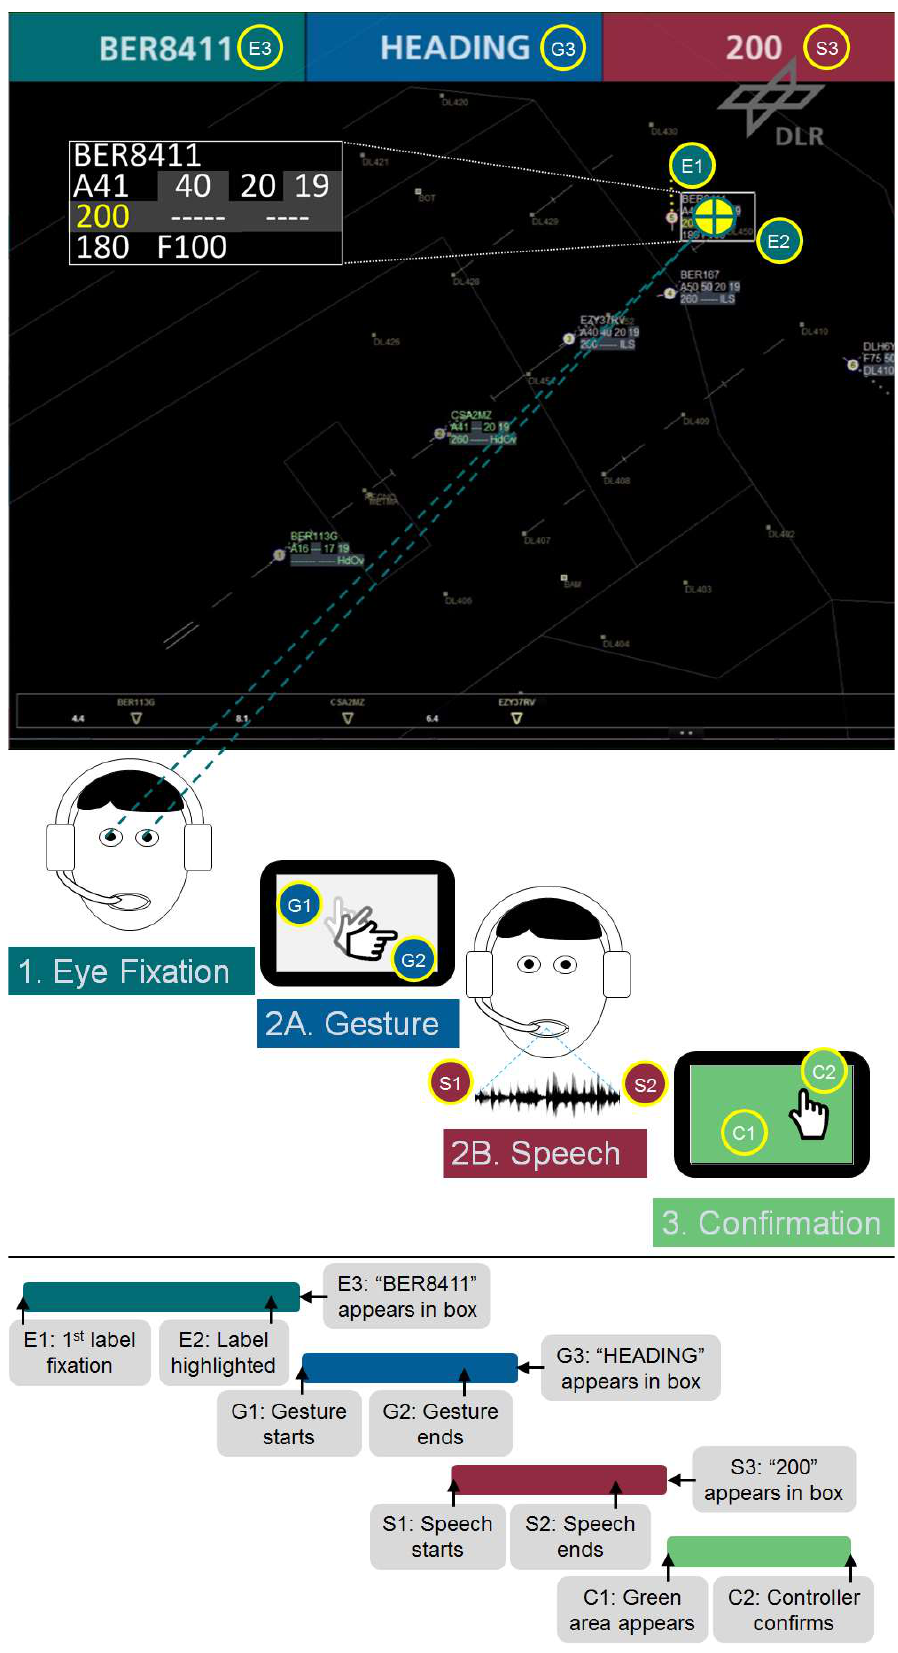
Figure 4. Measuring modality interaction and confirmation times when using multimodal controller working position (CWP) prototype TriControl.